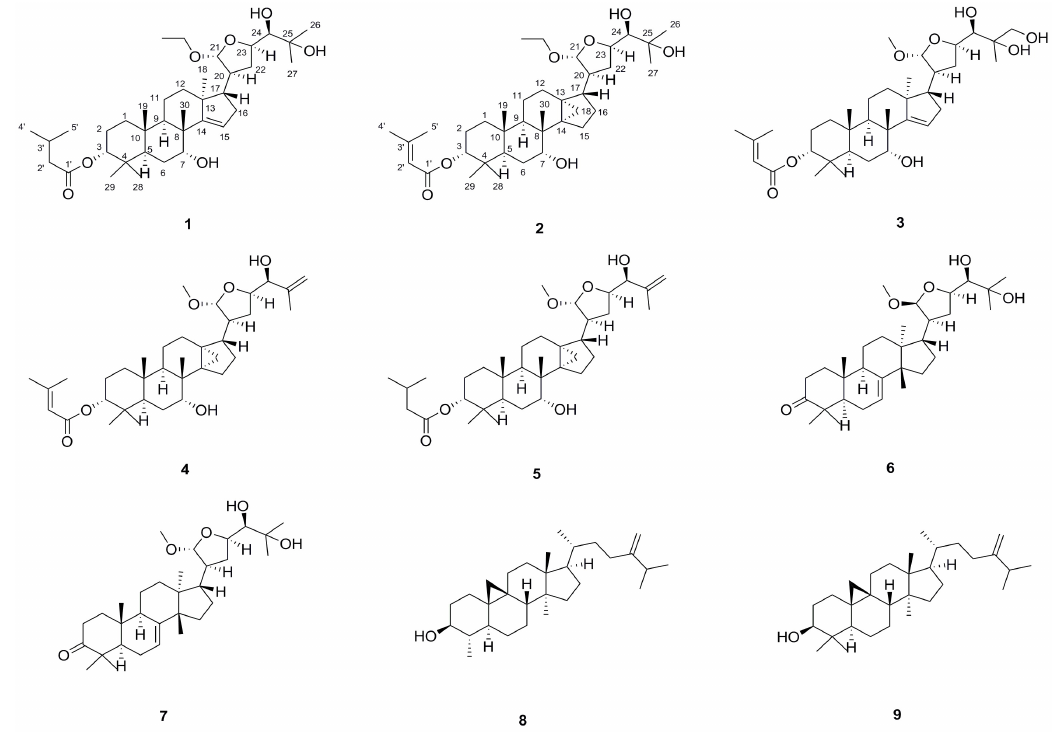
Figure 1. Structures of compounds 1 – 9 from the pericarp of T. sinensis .